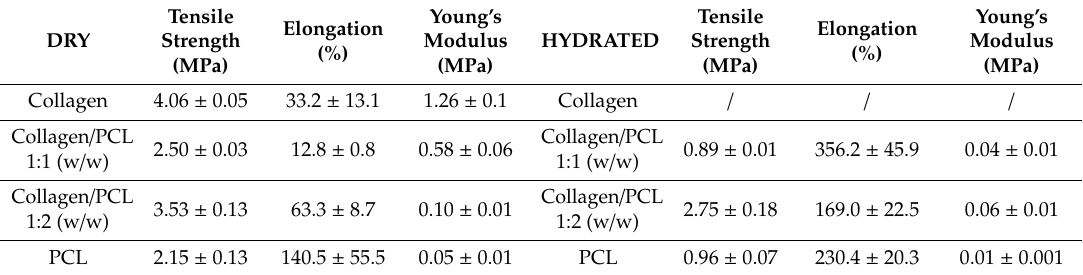
Table 5. Tensile strength (MPa), maximum strain and Young’s modulus (MPa) values of nanofibrous membranes evaluated at the dry and hydrated states. (mean values ± s.d., n = 6).